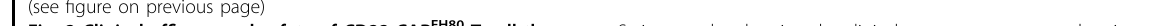
of CRS, ICANS, and other toxicities suspected to be related to CAR T cells are shown in Fig. 2f, g and Table S6. We further compared the severity of CRS and ICANS between CD22-CAR FH80 and the prior CD22- CAR YK002 therapies in the same individual patients but found no signi fi cant difference ( P = 0.414 and 0.285, Fig. S7). Serum cytokines indicative of systemic in fl am-